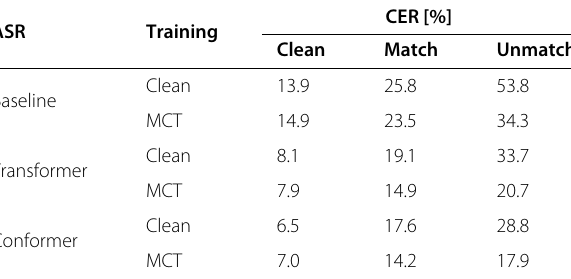
Table 3 The impacts of the enhancement front-end on the ASR systems trained by clean data and multi-condition training (MCT). The results are in CER [%]